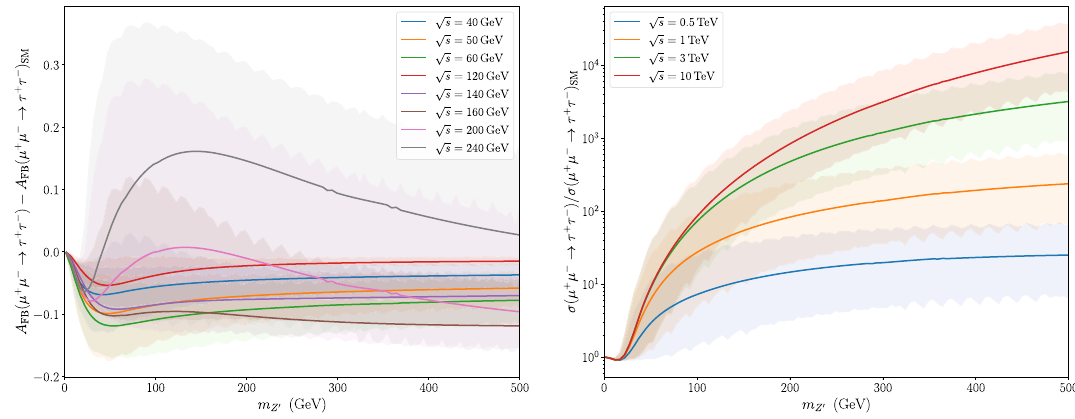
Fig. 15 Comparison of A FB (μ + μ − → τ + τ − ) (left panel) and of the production cross section σ(μ + μ − → τ + τ − ) (right panel) with the SM √ expectation, as a function of m Z (cid:2) for different values of